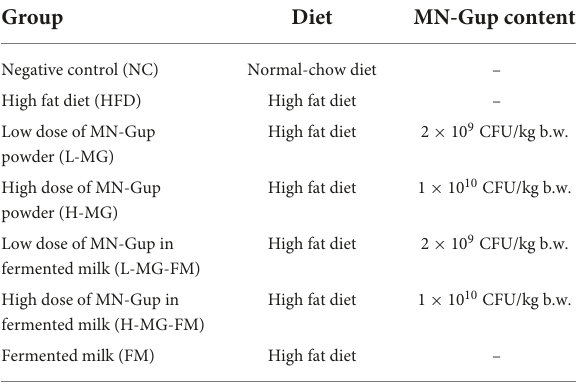
TABLE 1 Experimental groups and diet of